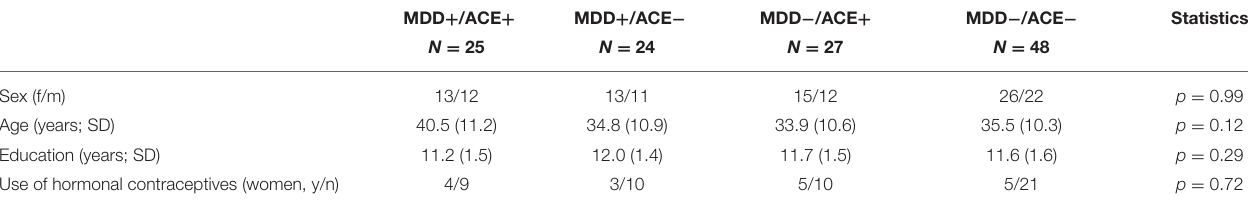
TABLE 1 | Sample characteristics of MDD patients with and without ACE and healthy participants with and without ACE.